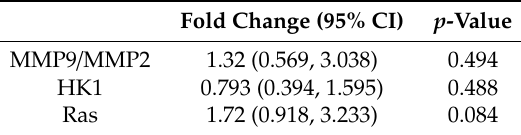
Table 3. Linear model of change in protein level from baseline to post metformin treatment